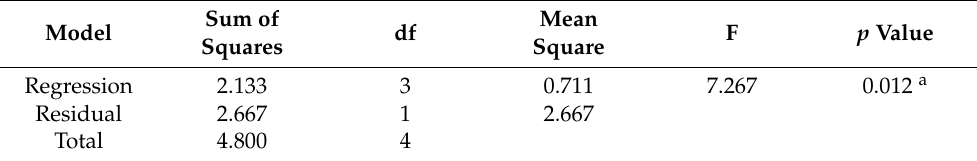
Table 9. Analysis of variance—Importance of the number of available charging stations.